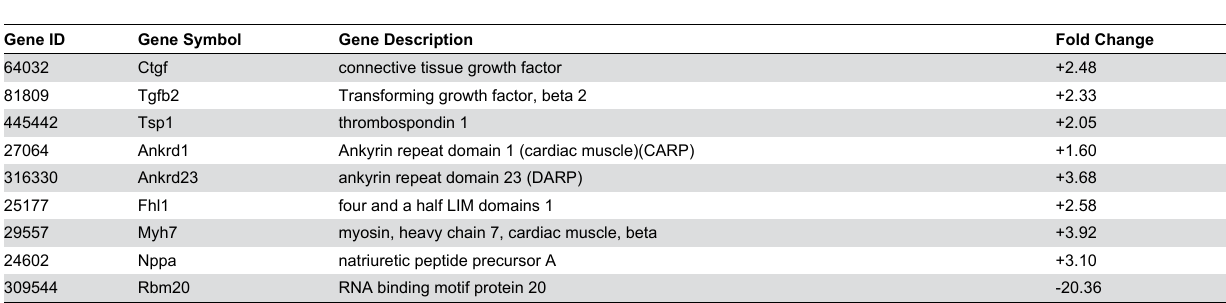
Wild type values were set at 1.00.